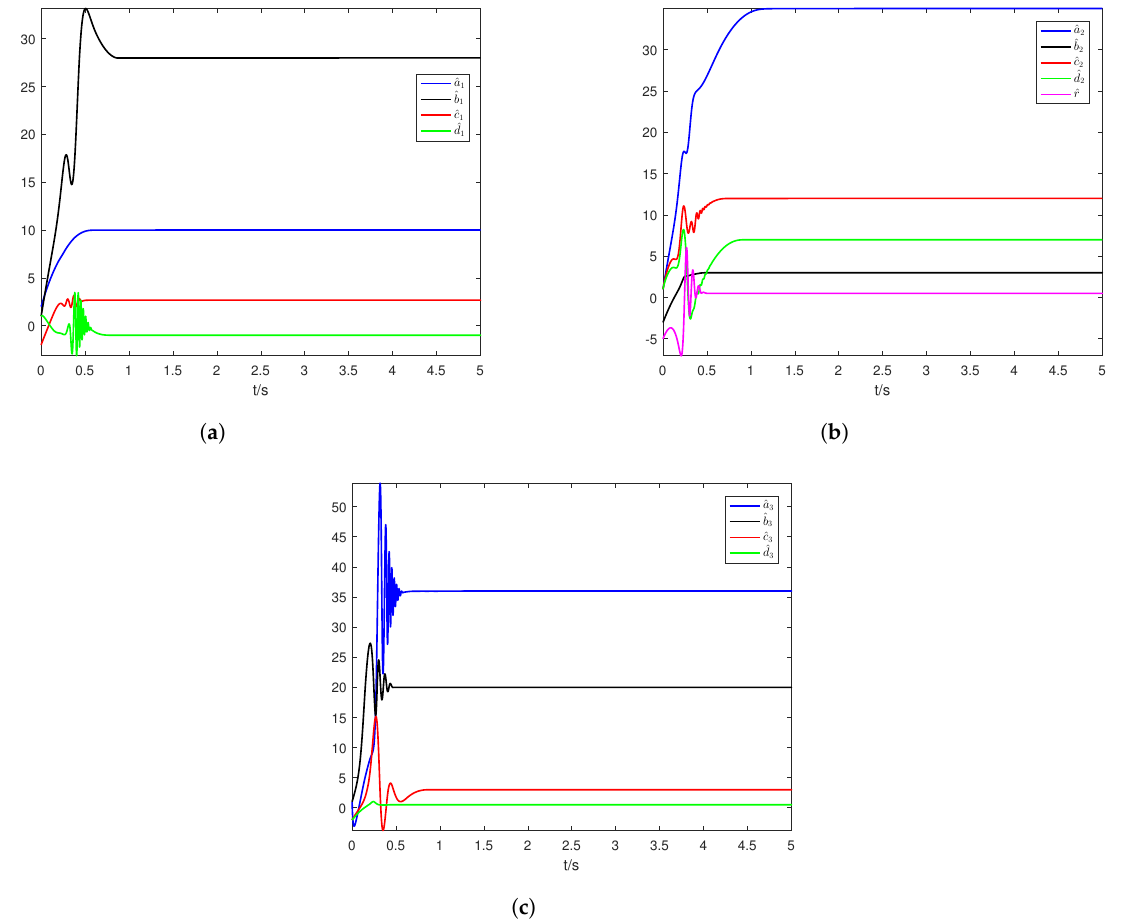
Figure 4. The estimation of parameters ˆ a 1 , ˆ b 1 , ˆ c 1 , ˆ d 1 of drive system (31) ( a ), ˆ a 2 , ˆ b 2 , ˆ c 2 , ˆ d 2 , ˆ r of drive system (32) ( b ), ˆ a 3 , ˆ b 3 , ˆ c 3 , ˆ d 3 of response system (33) ( c ).